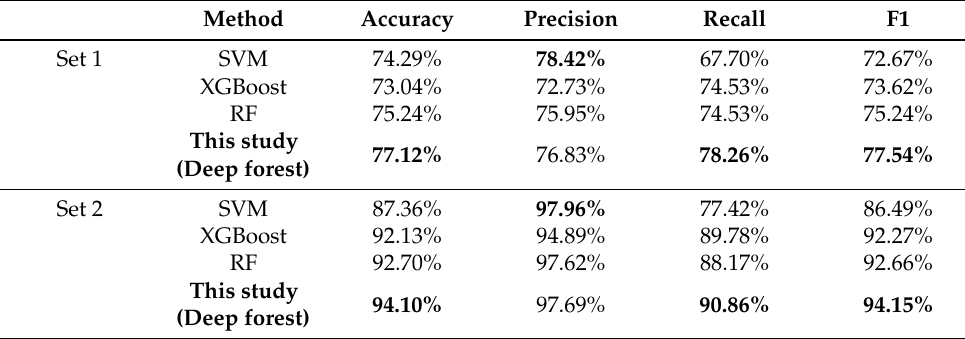
Table 2. Performance comparison results with baseline methods on independent test sets. Best performance values are in